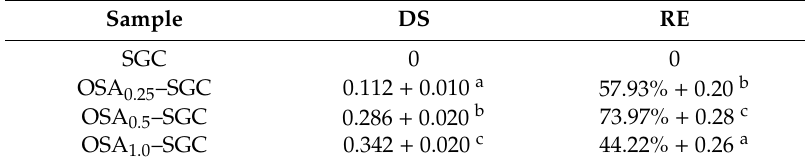
Note: Di ff erent letters in the same column indicate significant di ff erences, p < Note: Different letters in the same column indicate significant differences, p < 0.05.